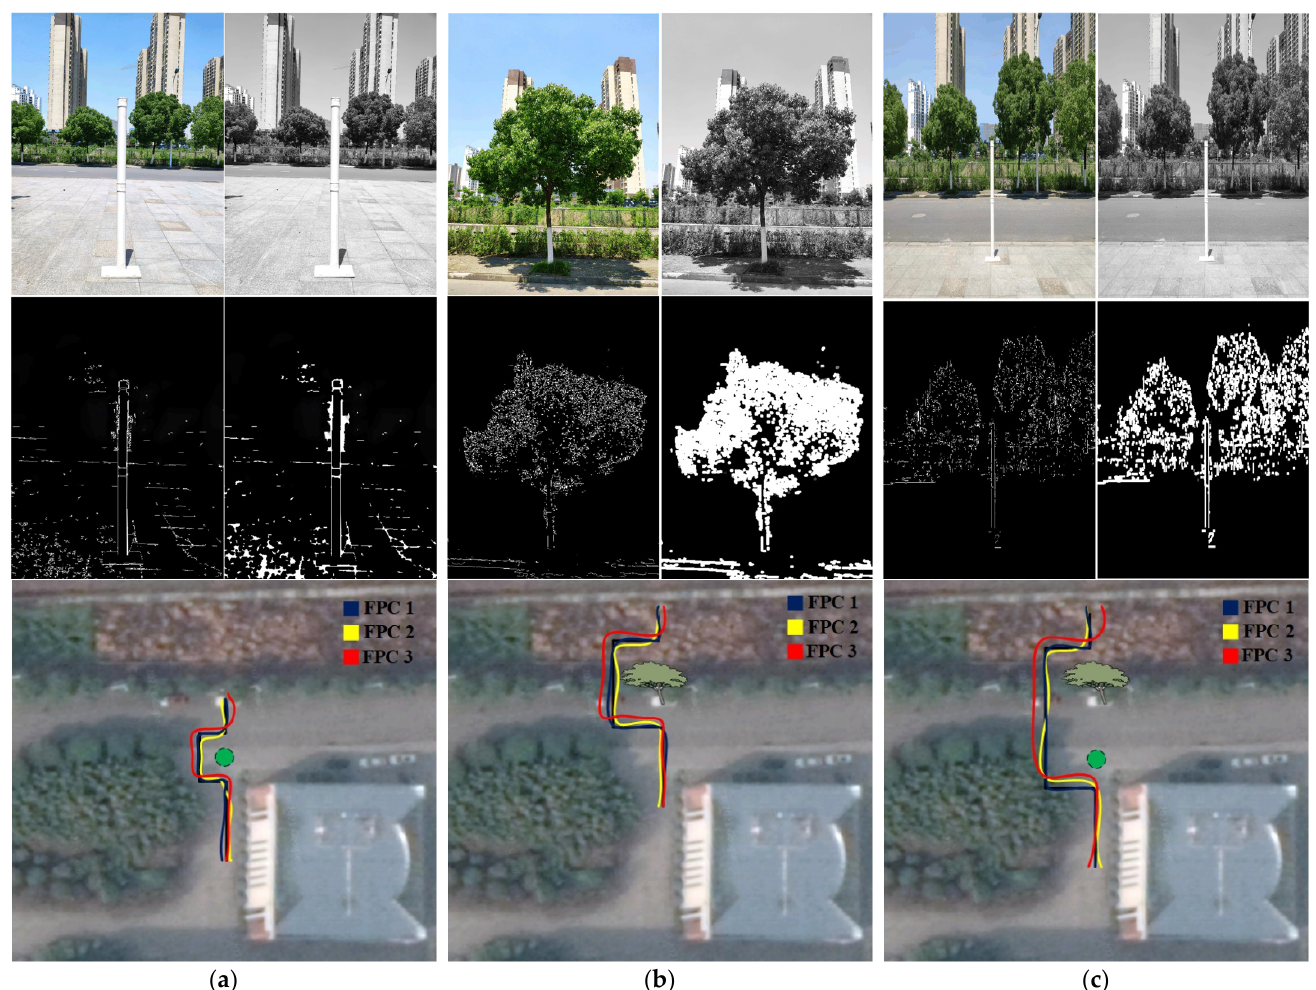
Figure 11. Obstacle avoidance flight experiments in different scenarios: ( a ) Scenarios A; ( b ) Scenarios B; ( c ) Scenarios C. Table 6. Minimum distance between UAV and obstacle under different scenarios and FPC.